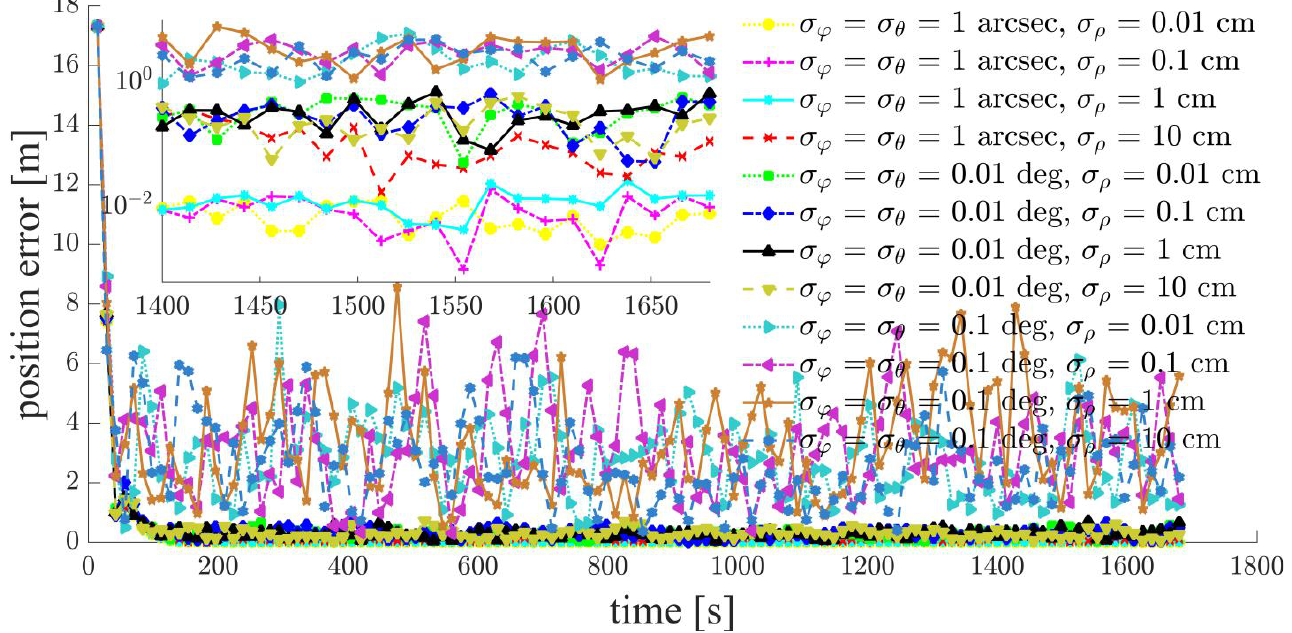
Figure 16. Relative navigation errors of 𝑆 6 (simulated scenario: Case d, space-circle formation radius of 1 km). The inter-satellite RF angle measurement accuracy can reach 0.01 deg, and the inter- satellite RF range measurement accuracy is at the centimeter-level for the distributed multi-satellite measurement scheme. Under this condition, the relative navigation results shown in Figures 11 – 16 are summarized in Table 4. As inferred above, the relative navigation algorithm for the deputy satellites will di- verge in Case e; this is verified by the simulation results in Figure 17. Therefore, no statis- tics are presented for Case e .